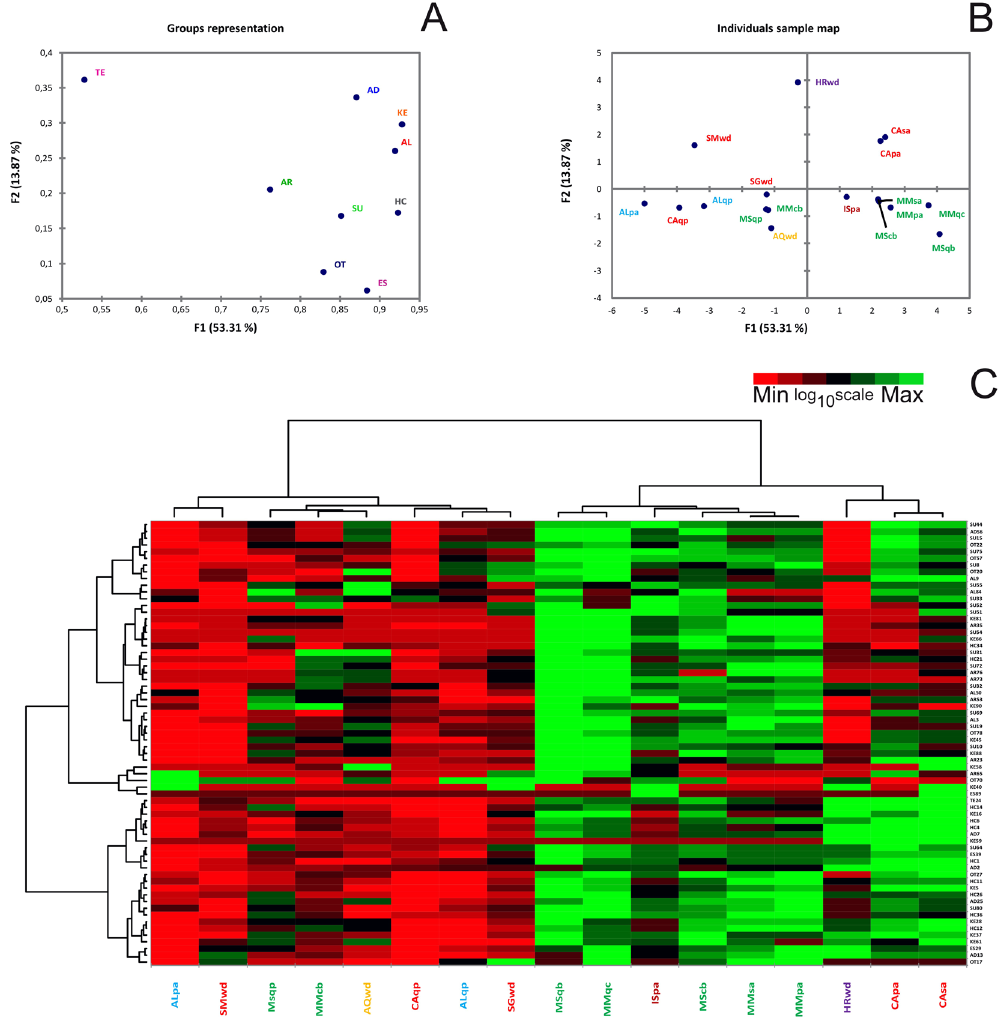
Figure 1. Multiple factor analysis (MFA) of VOCs analysed by PTR-TOF. F1 = first dimension, F2 = second dimension. Data were processed by log 10 + 1 transformation. ( A ) Representation of groups of variables. Key codes: AL = Alcohols; AD = Aldehydes; AR = Aromatic compounds; ES = Esters; HC = Hydrocarbons; KE = Ketones; OT = Others; SU = Sulfur containing compounds; TE = Terpenes. ( B ) Representation of the selected samples in the multidimensional space of the MFA (F1, F2). The total inertia ( i.e ., total variance) included in the first two dimensions of the MFA was 67.19%. ( C ) Heat map based on the quantitative data obtained from PTR-TOF analysis. The samples analysed are listed in Table 1, while compounds identified through PTR-TOF analysis are reported in the Supplementary Information (Table S1). Data were log 10 + 1 transformed.